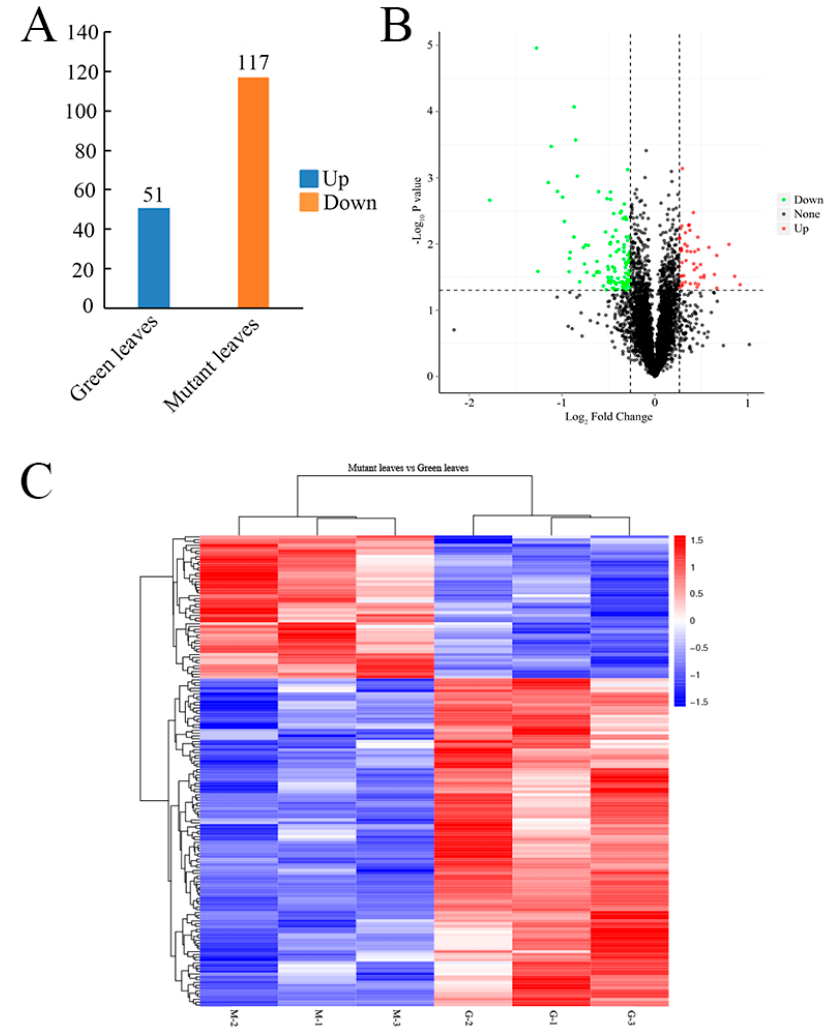
Figure 4. Identified differentially accumulated proteins between green and mutant leaves. ( A ) Volcano plot of all DAPs in mutant compared with green leaves. ( B ) Quantitative analysis of the proteome between green and mutant leaves. In green (down-regulated) and in red (up-regulated): proteins with p < 0.05 and |log 2 FC| > 0.26; in black: proteins alone. ( C ) Hierarchical cluster analysis of DAPs. The color spectrum from blue to red indicates protein expression intensity, ranging from low to high, respectively. Green leaves-1, G-1; Green leaves-2, G-2; Green leaves-3, G-3; Mutant leaves-1, M-1; Mutant leaves-2, M-2; and Mutant leaves-3, M-3.